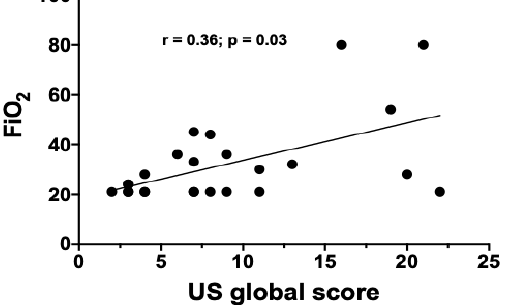
Figure 2. Correlation between lung ultrasound (US) global score and FiO 2 in the subgroup of patients undergoing US examination.